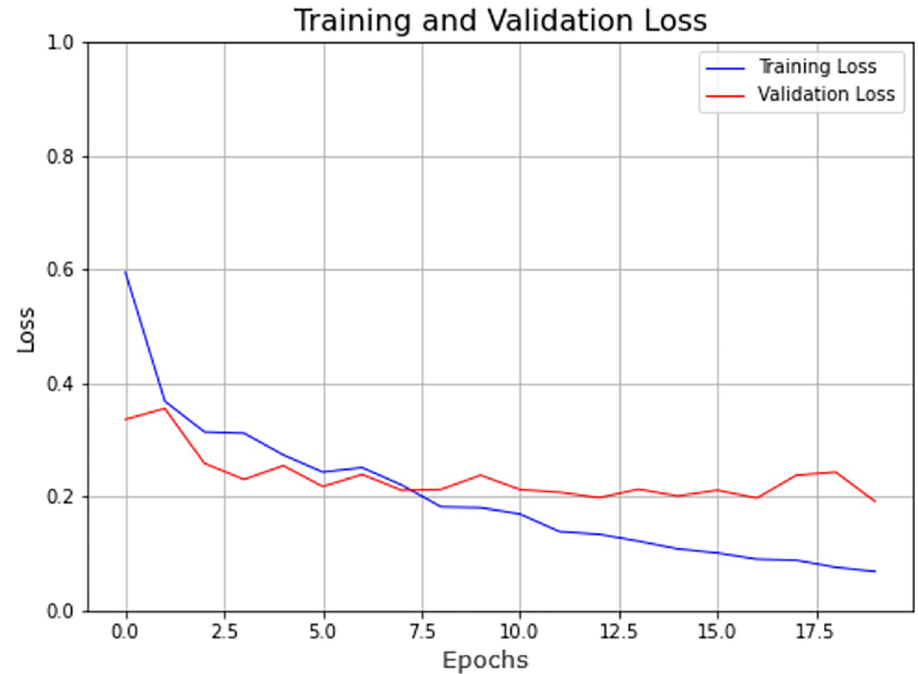
Fig 9. Loss for VGG-16